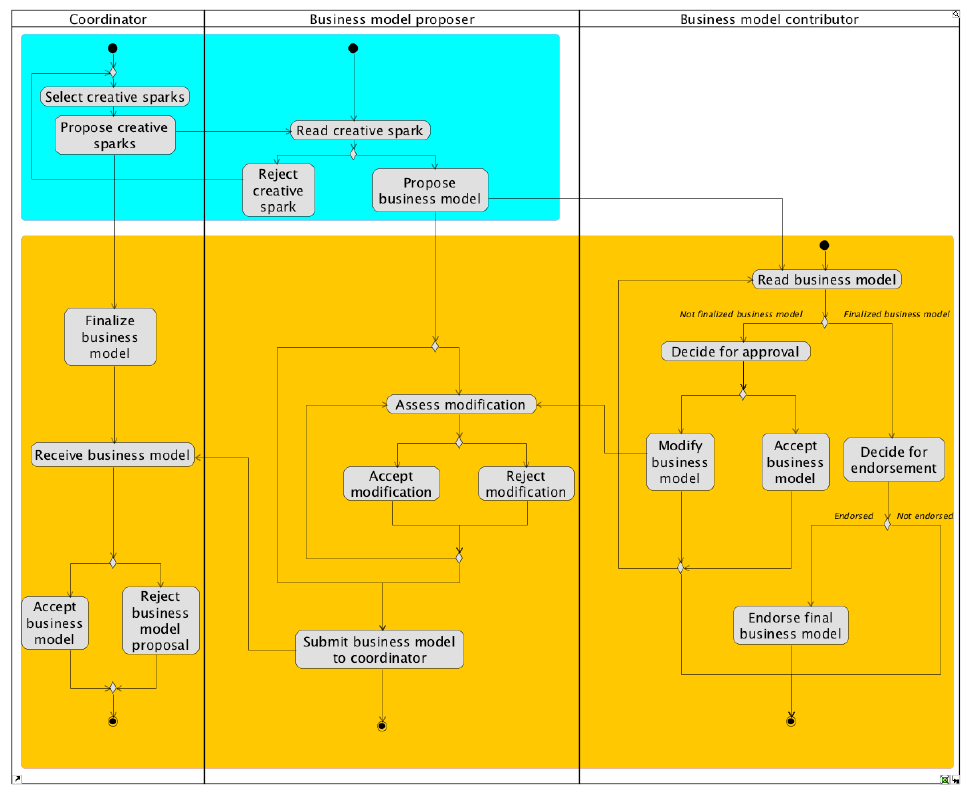
Figure 6. Gamified collaboration for definition of a business model. Activities performed at the individual level are in the blue boxes, whereas the iterated activities of evaluation and refinement of business models, performed collaboratively, are in the orange